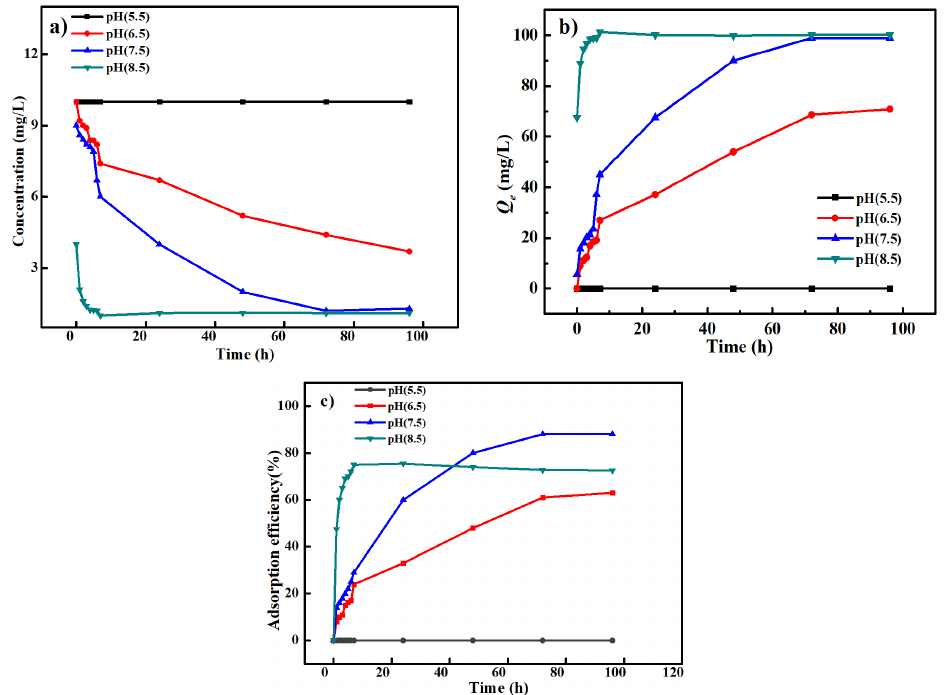
Figure 9. The Cd 2+ adsorption concentration ( a ), adsorption capacity Q e ( b ), and adsorption efficiency ( c ) of the carbonized ZIF − 8@PAN nanofiber membrane at different pH values and the adsorption temperature of 35 °C.